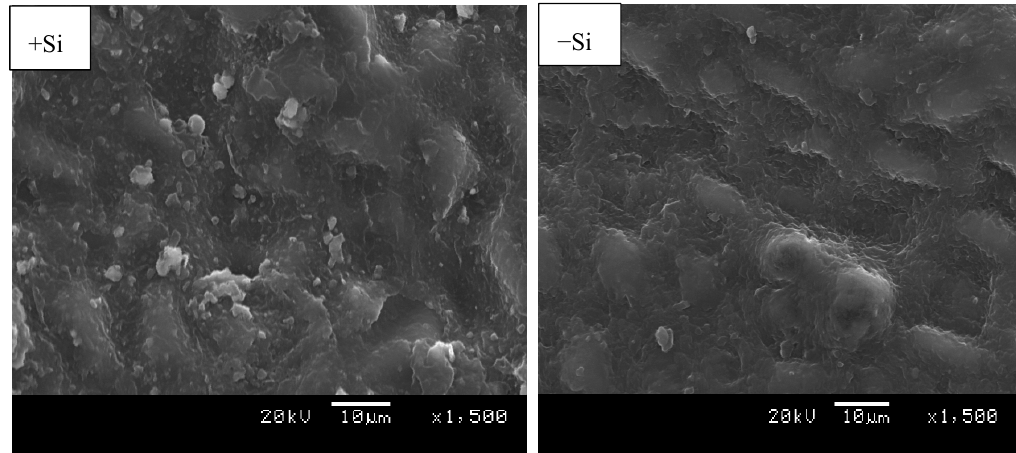
Figure 4. Environmental scanning electron microscopy (ESEM) micrographs of +Si and -Si matured citrus leaves, the white granules are areas of silicon detection on the adaxial leaf surfaces.